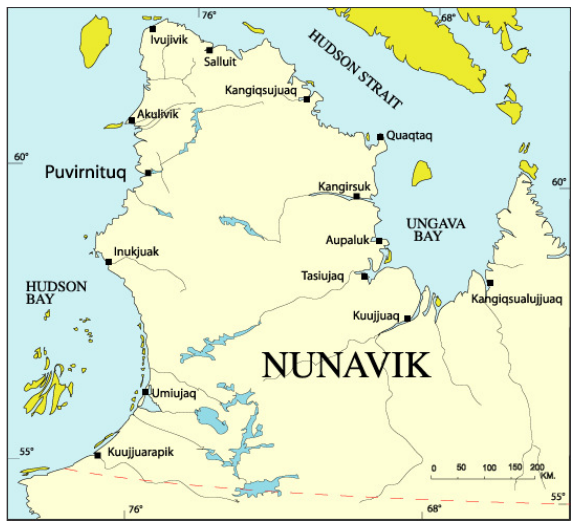
Figure 1. Nunavik and its 14 Inuit communities. Source: Makivik Corporation